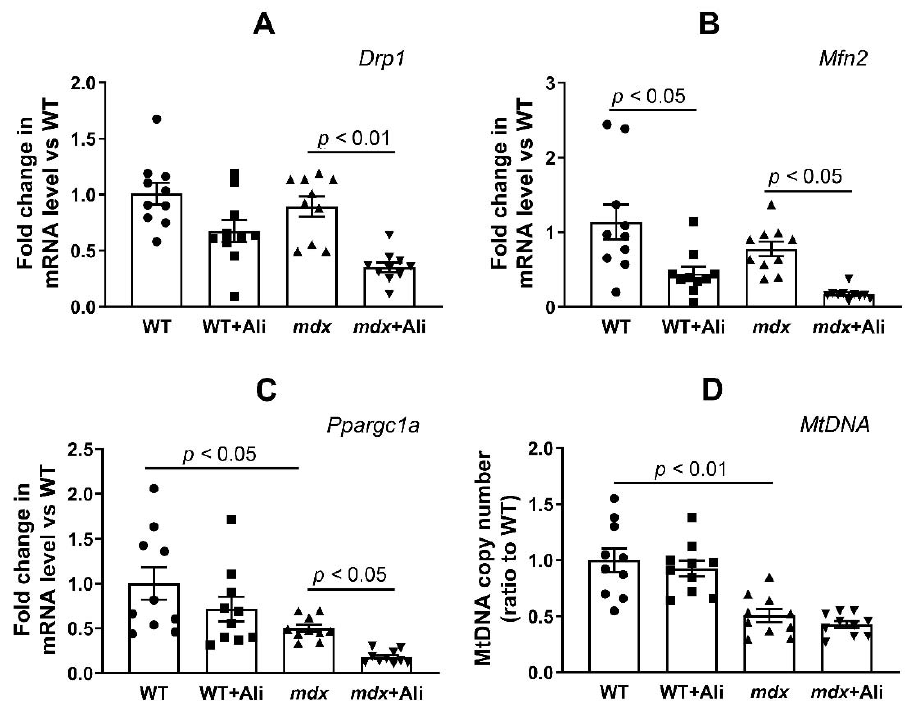
Figure 9. The effect of alisporvir on mitochondrial dynamics and biogenesis in skeletal muscle. The relative mRNA levels of Drp1 ( A ), Mfn2 ( B ), Ppargc1a ( C ), and mtDNA level ( D ) in the skeletal muscle of experimental animals. The data are presented as means ± SEM ( n = 10).